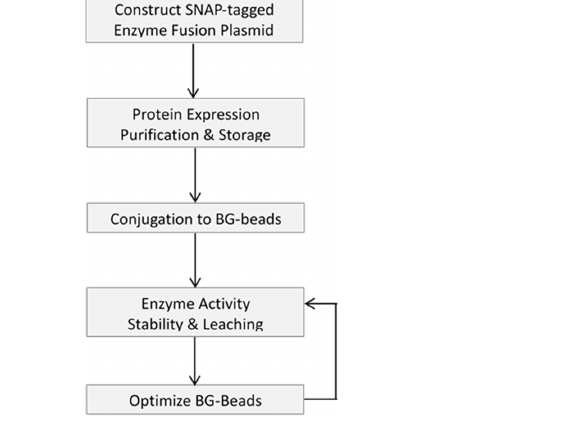
Figure 1. Framework for study of enzyme immobilization using SNAP-tag technology.